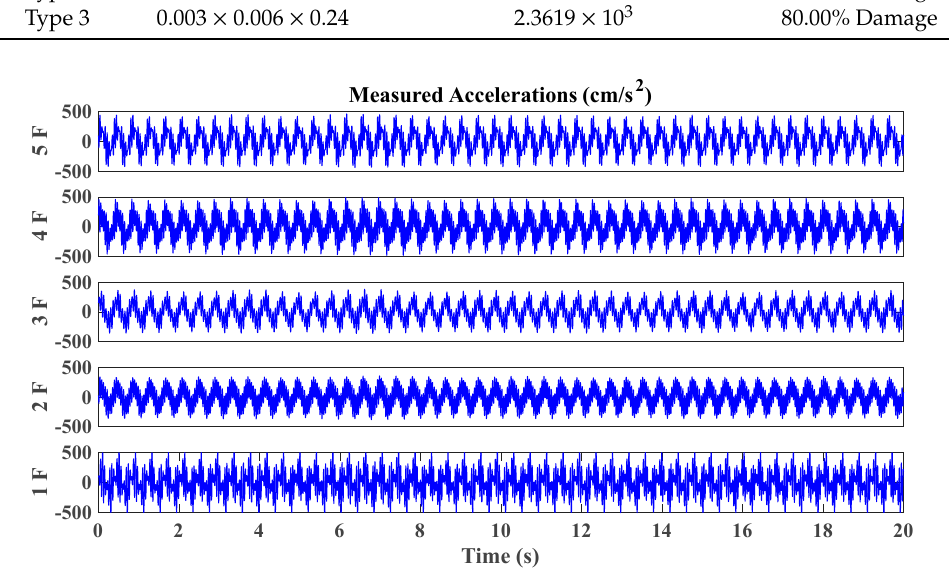
Figure 16. Typical acceleration time histories of small ‐ scale shear framework structure excited by sine sweeping ‐ frequency excitation.